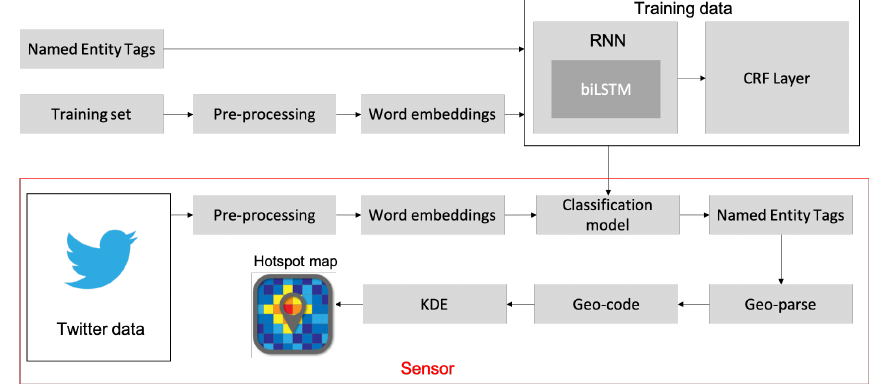
Figure 3. Proposed Twitter-based social sensor for natural disasters.